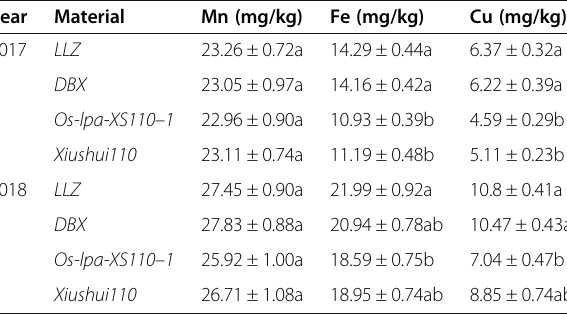
Table 1 Contents of Fe, Mn and Cu in the brown rice of the mutant lines and their wild type